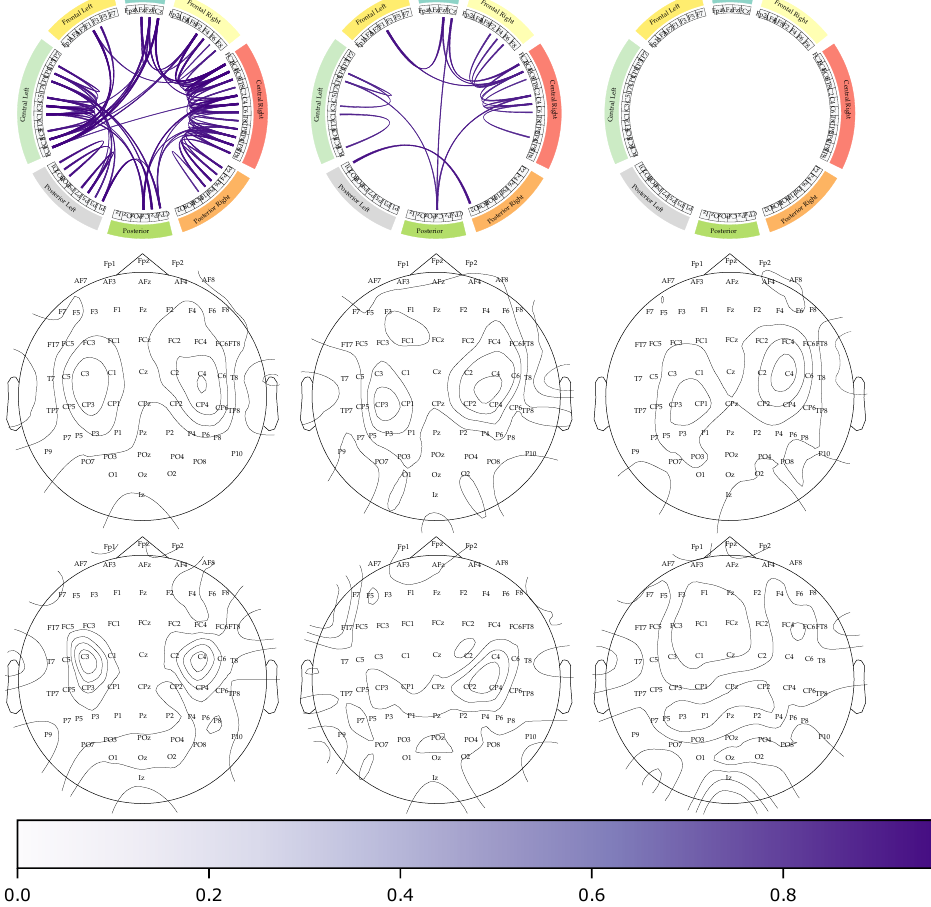
Figure 9. KSC-FCnet functional connectivity results (Circos plots and topoplots). The first row illustrates the 99th percentile of the most significant functional connections across the centroid subjects concerning the studied best, medium, and worst performance clusters (see Figure 2), with the opacity representing the strength of the connectivity. The second and third rows display topoplots of the two-sampled Kolmogorov–Smirnov test and the weights of the classification layer on the KCS-FCnet, respectively. The purer the purple color, the more important the brain area is. The left to right column represents each group from G I to G